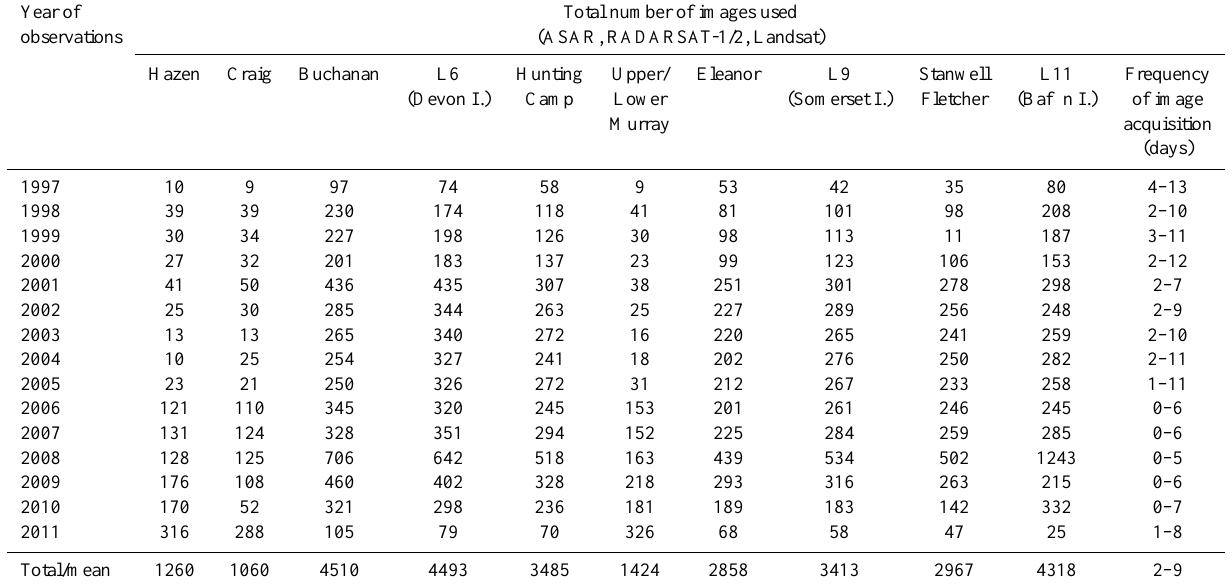
Table 2. Summary of yearly number and frequency of satellite images used for the ice cover monitoring of the investigated High Arctic lakes during the break-up season from 1997 to